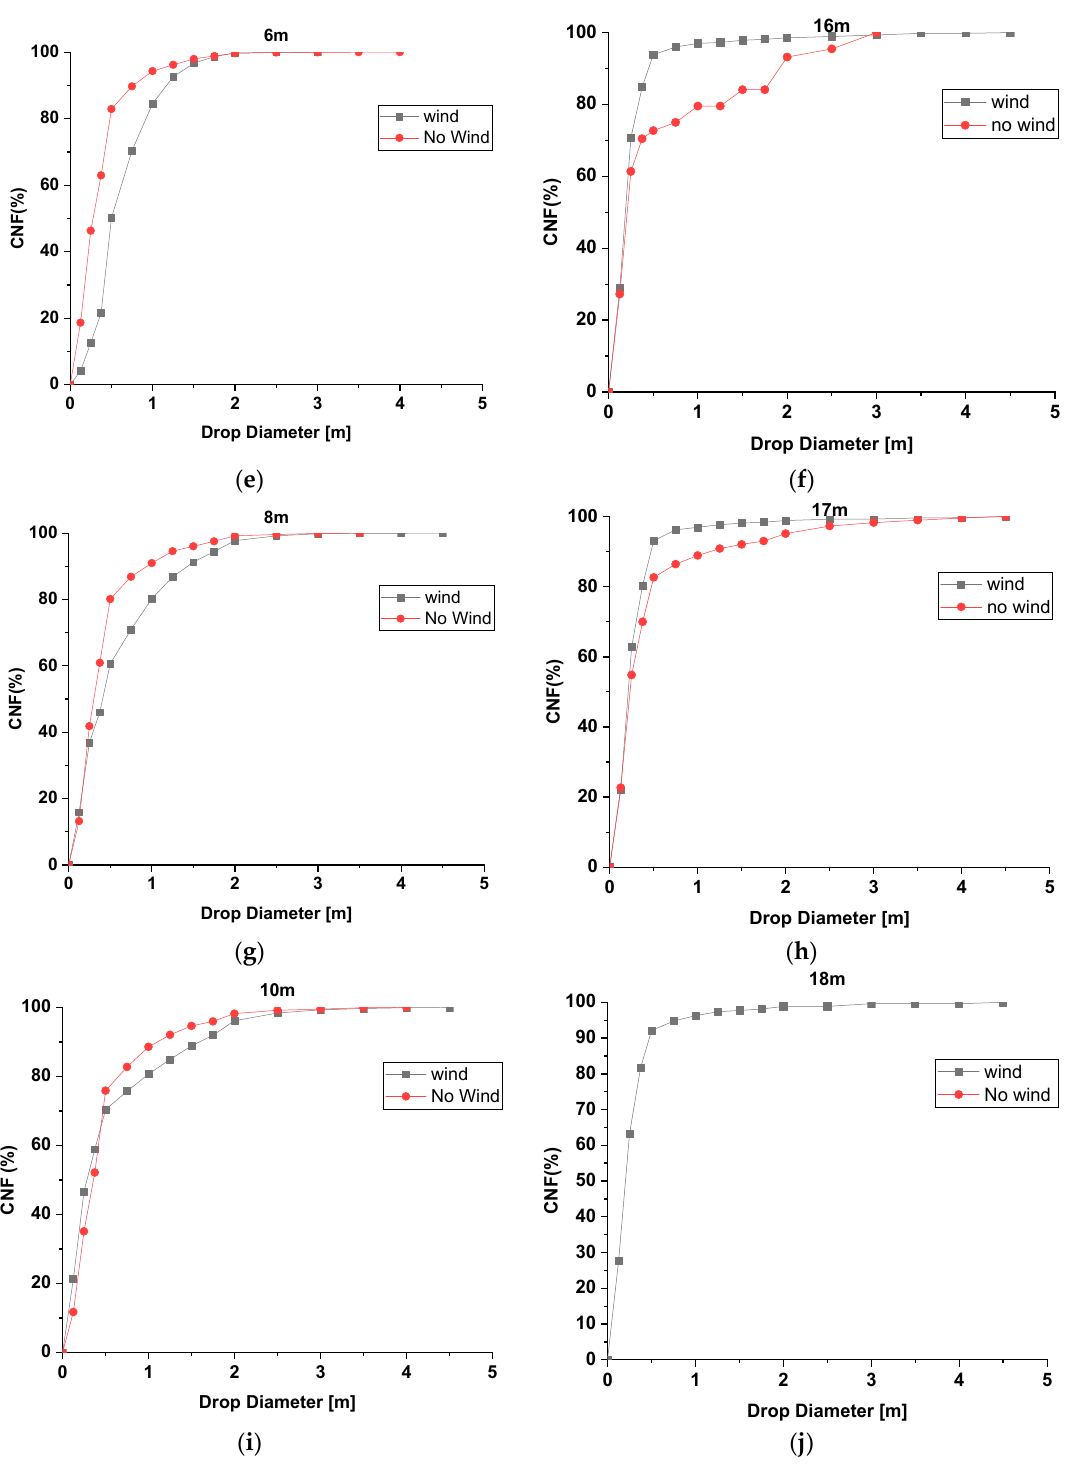
Figure 5. Comparison between the cumulative numeric frequency (CNF) droplet distribution curves in wind (wind speed: ranged between 0 to 2 m/s, average wind speed at 1.25 m/s with wind direction along the direction of throw) and in no-wind at different distances from the sprinkler at 300 kPa. Where ( a ) is CNF vs. Drop diameter at 2 m; ( b ) CNF vs. Drop diameter at 12 m; ( c ) CNF vs. Drop diameter at 4 m ( d ) CNF vs. Drop diameter at 4 m ( e ) CNF vs. Drop diameter at 6 m ( f ) CNF vs. Drop diameter at 16 m; ( g ) CNF vs. Drop diameter at 8 m; ( h ) CNF vs. Drop diameter at 17 m; ( i ) CNF vs. Drop diameter at 10 m; ( j ) CNF vs. Drop diameter at 18 m.